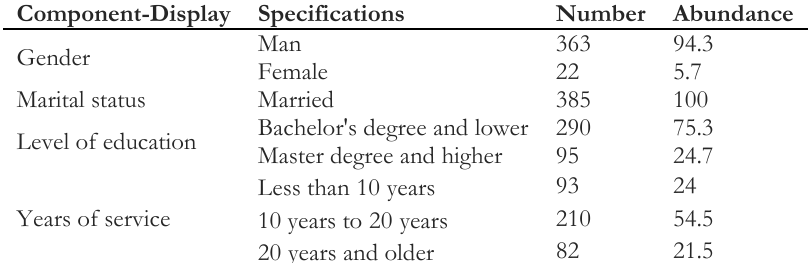
Table 1. Summary of description population cognitive sample